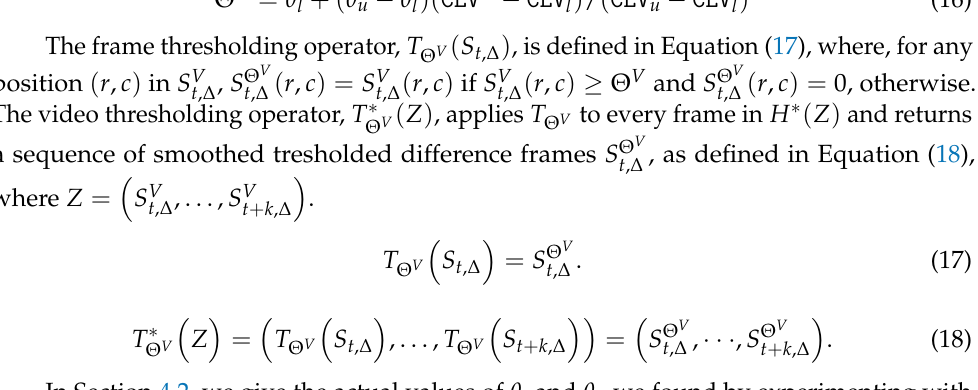
Figure 6. V 1 is a low bee traffic video with 745 frames; B V 1 is the maximum color variation frame for V 1 ; V 2 is a high bee traffic video with 745 frames; B V 2 the background frame of V 2 ; MXV V 2 is maximum color variation frame for V 2